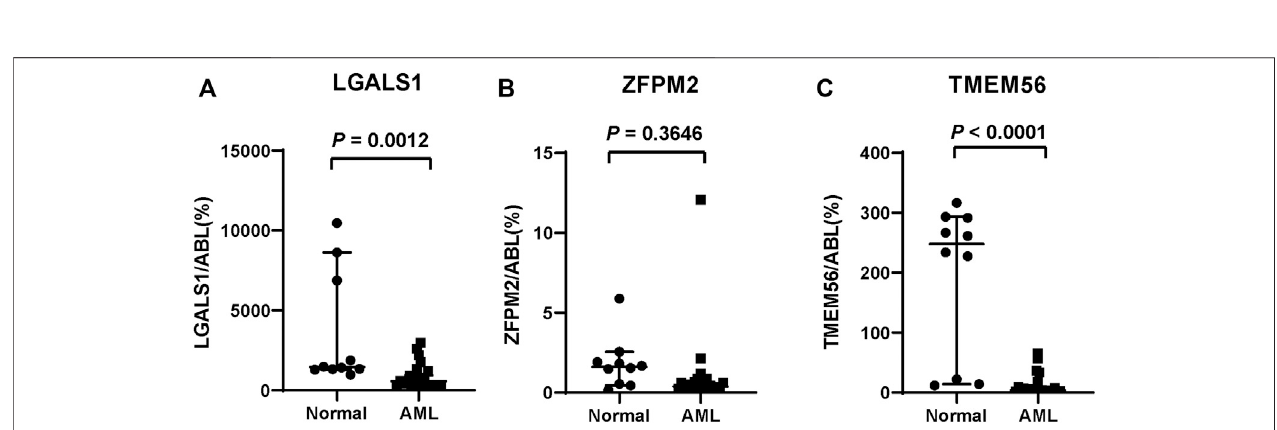
FIGURE 11 | In vitro validation of three risk genes. (A) LGALS1, (B) ZFPM2, (C) TMEM56 mRNA expression level in the normal and AML samples.